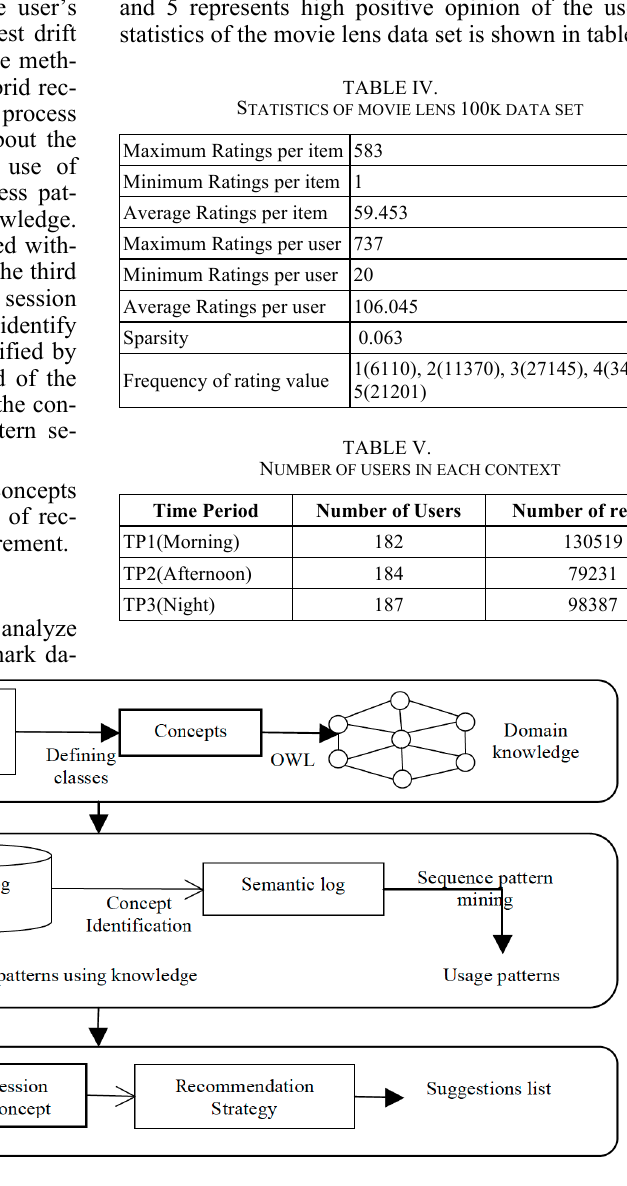
Figure 2. Layered Architecture of the Proposed Recommender